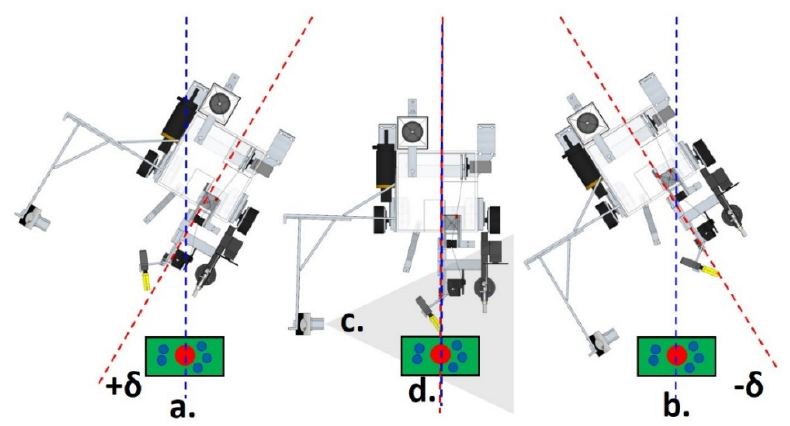
Figure 4. Implementation of the unsupervised method of the environment scanning process. ( a ) Sweep Angle +𝛿 position; ( b ) Sweep Angle −𝛿 position; ( c ) Side Camera; ( d ) Target and its possible locations.